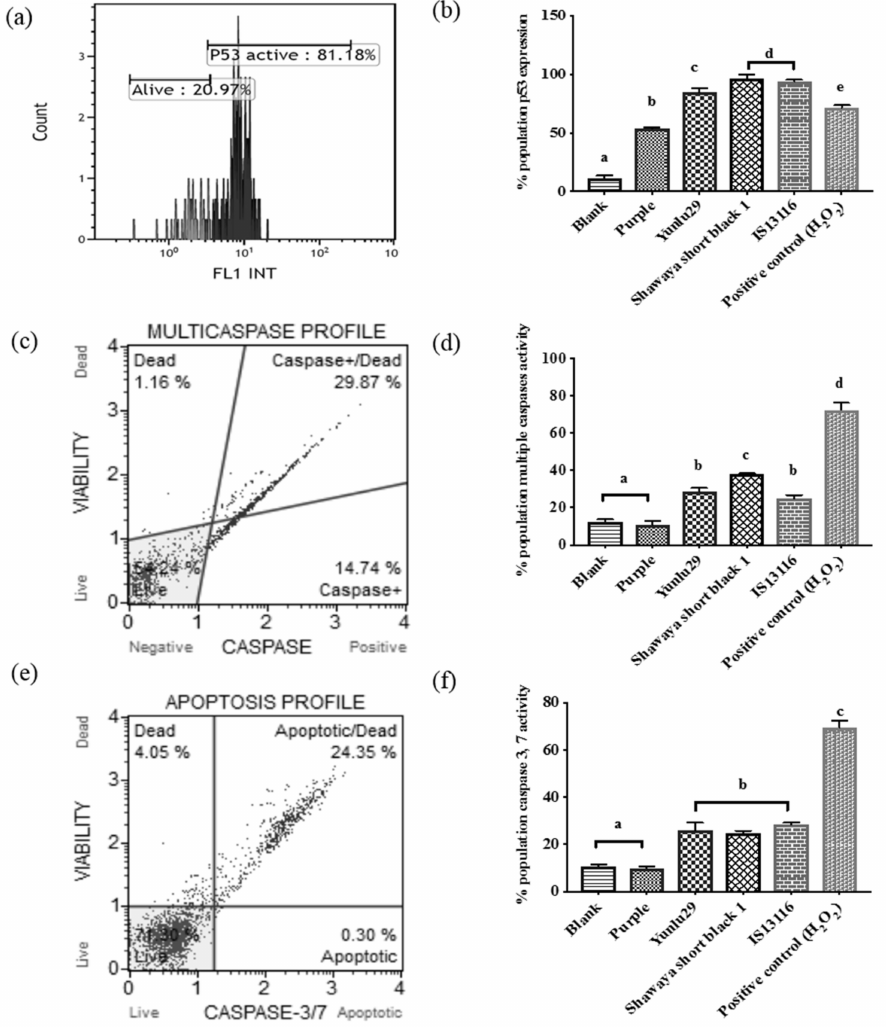
Figure 4. ( a ) Yunlu29 Flow cytometric histogram of p53 expression, ( b ) proportion of p53 expression, ( c ) Muse plot parameters for detection of multiple caspase activity ( d ) percentage of multiple caspase activity ( e ) Muse plot parameters for detection of caspases 3 and 7 ( f ) percentage of caspases 3 and 7 activity, in SW480 cells treated with rice and sorghum extracts. Bars with di ff erent letters represent significant di ff erence in activity, results presented as mean ± standard deviation (n =